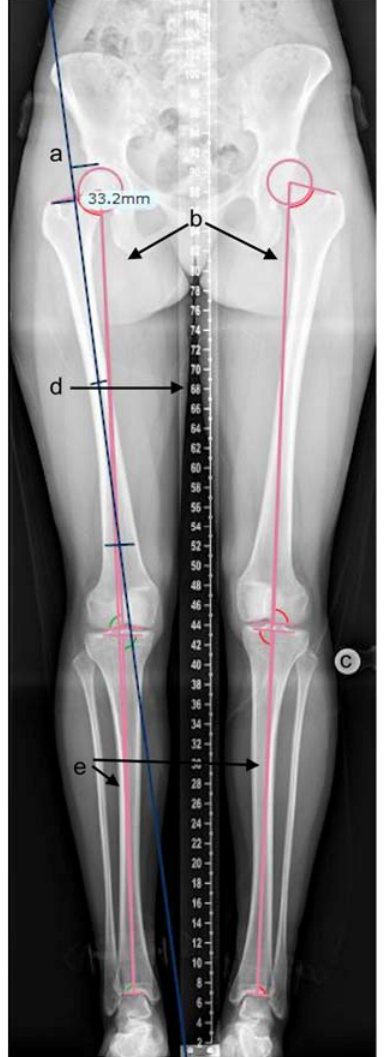
Figure 1. TraumaCad measurement of leg length parameters. (a) tool for articulo ‐ trochanteric dis ‐ tance, (b) femoral length tool, (c) templating ball for calibration, (d) measuring ruler, (e) tibial length